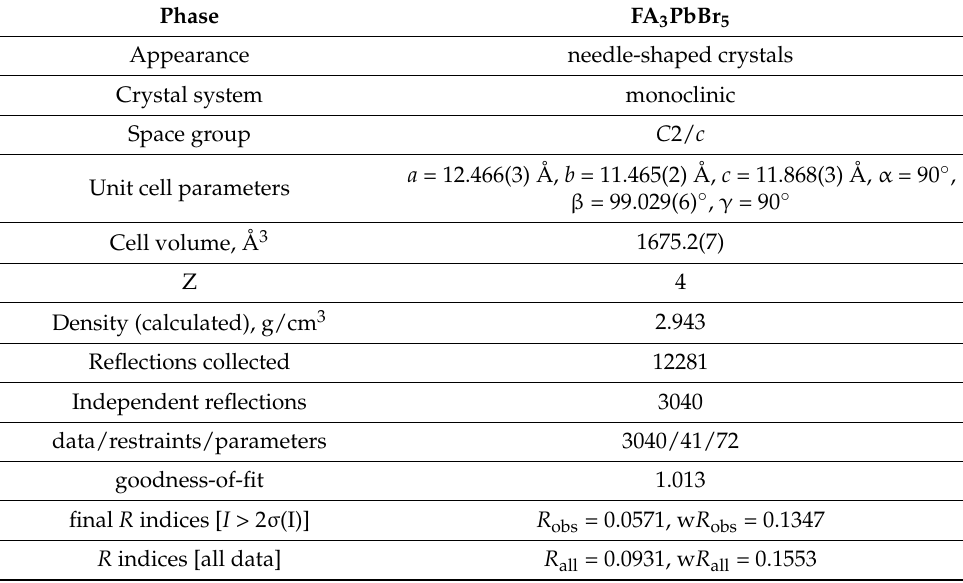
Table 1. Crystal and refinement data for new FA 3 PbBr 5 phase.